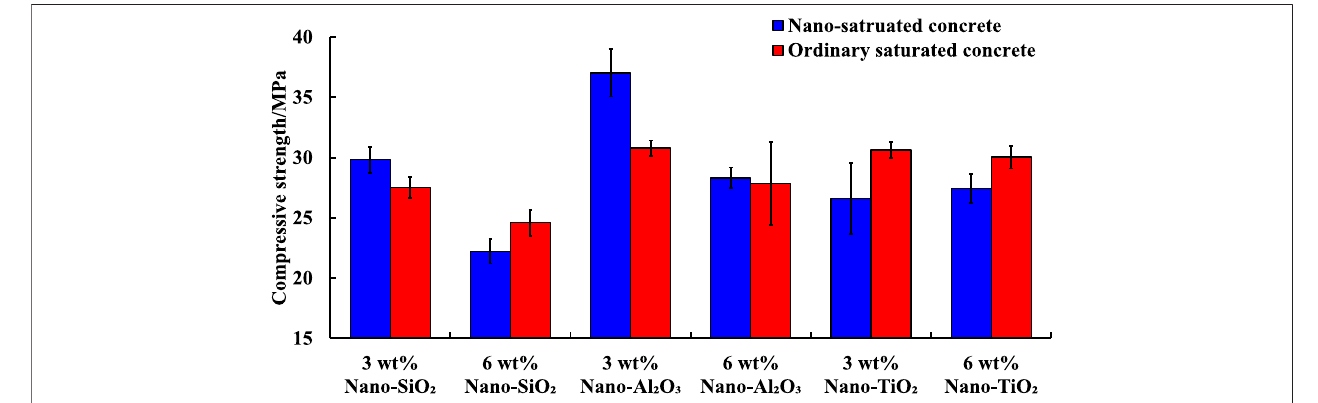
FIGURE 7 | Compressive strength of various types of saturated concrete samples.